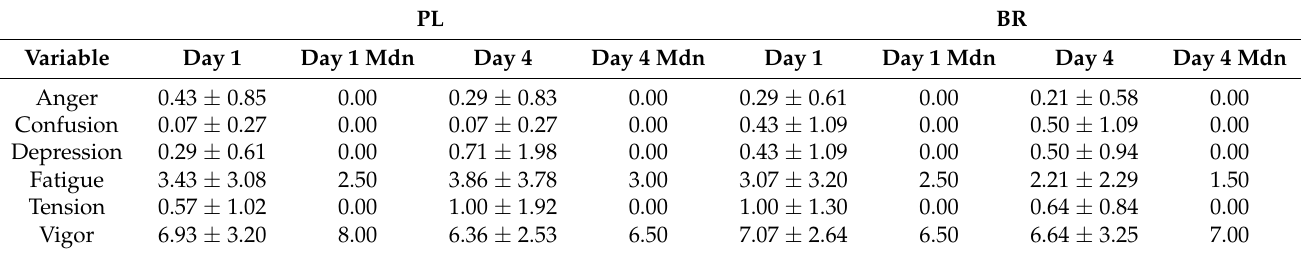
Table 2. Summary of variations in mood across all experimental visits.